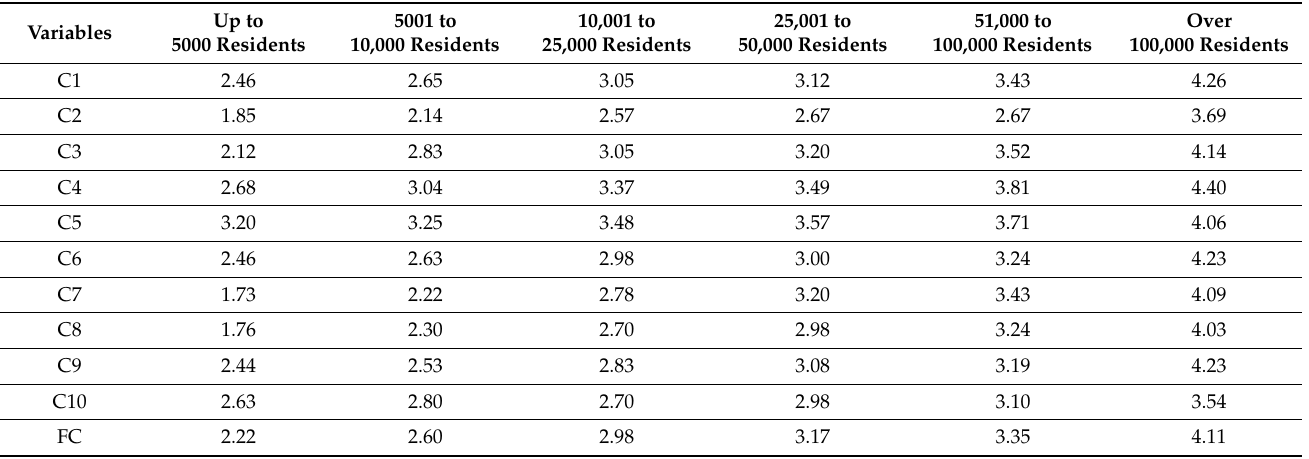
Table 5. Rating of variables in the functioning of the creative sector in Polish cities from the point of view of the city size.